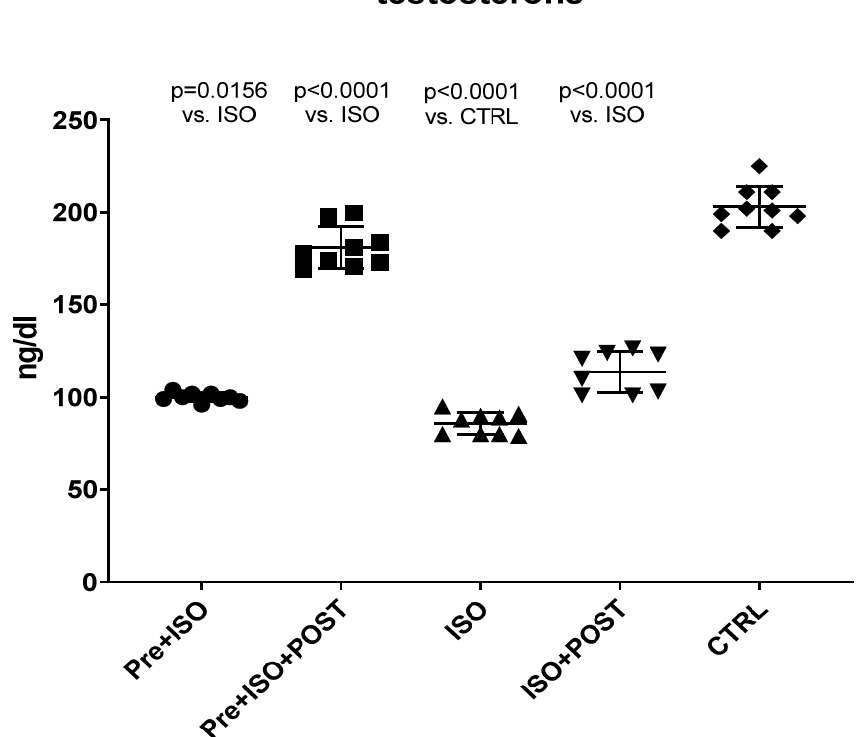
Figure 1. Changes in serum testosterone levels (ng/dL) as a result of isoproterenol treatment and exercise training. The results are shown as mean ± S.D., n = 8–9/group, one-way ANOVA, Tukey’s post-test. Significant differences between treatment groups are shown with exact p values. PRE = Pre-swimming, ISO = Isoproterenol injection, POST = Post-swimming, CTRL = Control group.